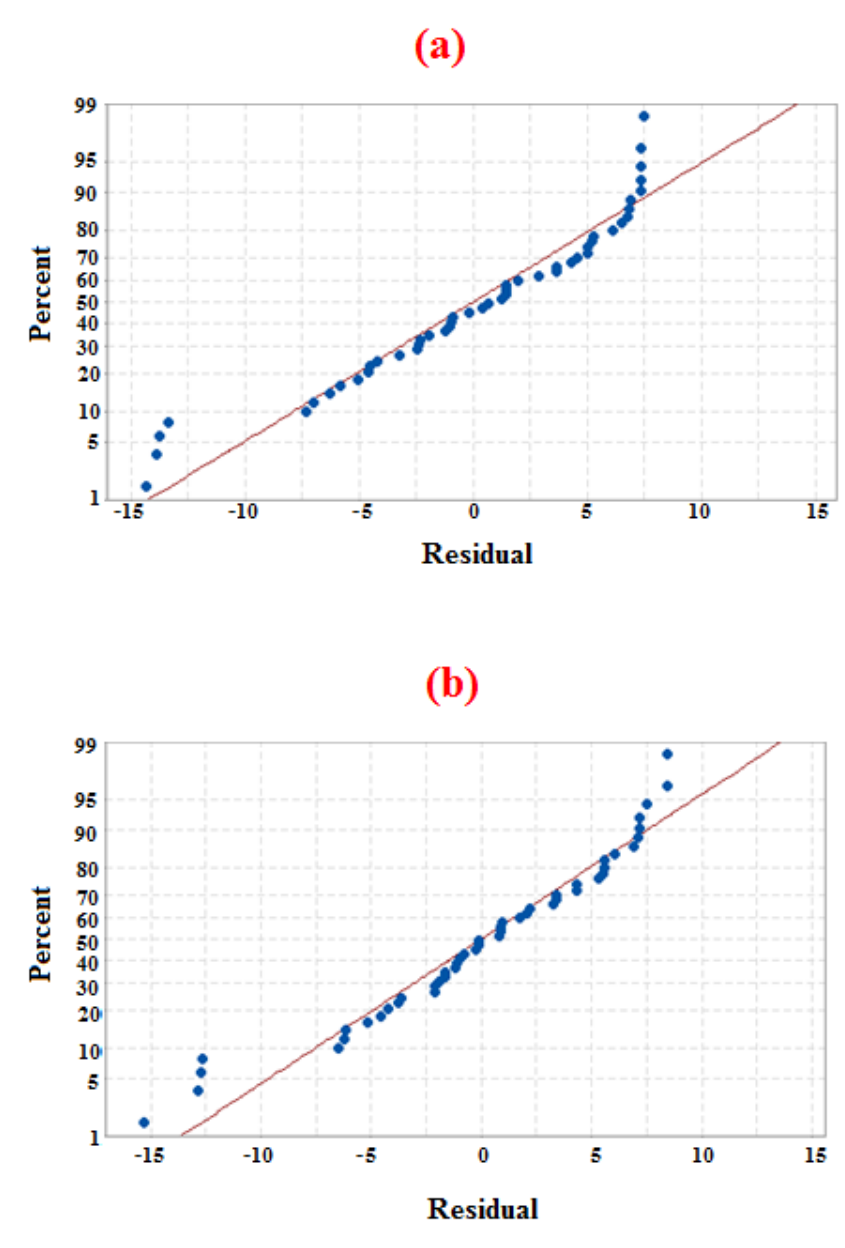
Figure 4. Normal probability plot of the residuals for the permeability of ( a ) AB — 210, and ( b ) RB dyes.